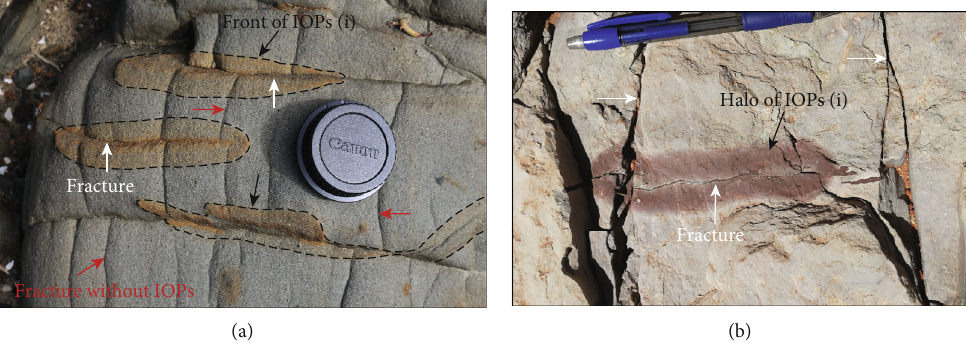
Figure 7: Not all fractures act as conduits for fl uid fl ow, and hence iron oxide precipitates do not surround all fractures. Along-strike variability of the fractures may cause along-strike variability in the distribution of iron oxide precipitates. Examples from (a) Hokianga, New Zealand and (b) the footwall of the Moab Fault in Arches National Park. White arrows point to the areas of fractures associated with iron oxide precipitates, while the red arrows point towards some of the fractures which do not promote formation of iron oxide